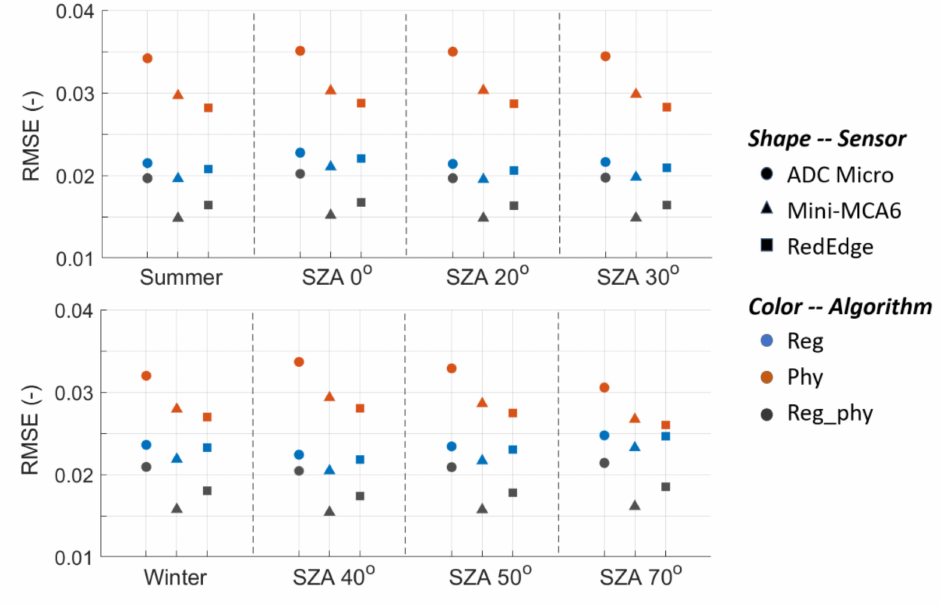
Figure 5. RMSEs of the three model-based estimated total SW albedos with respect to the season and SZA.